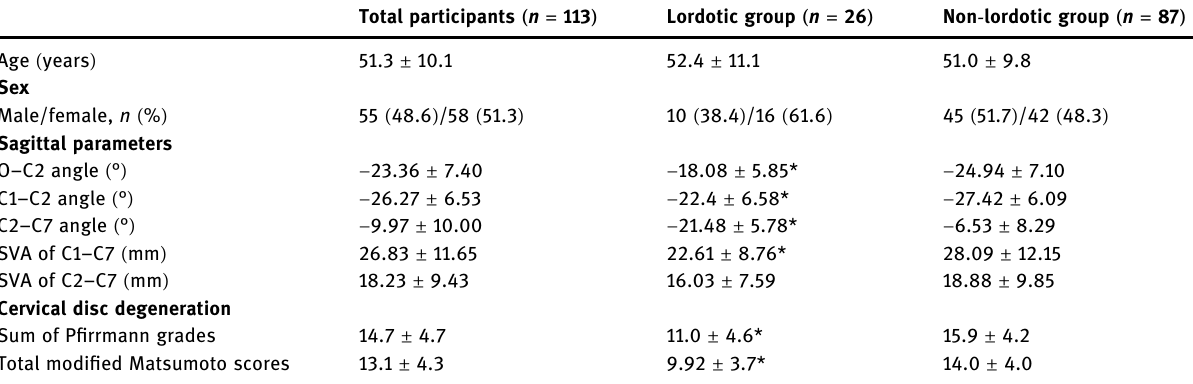
Table 1: Baseline demographic characteristics of participants